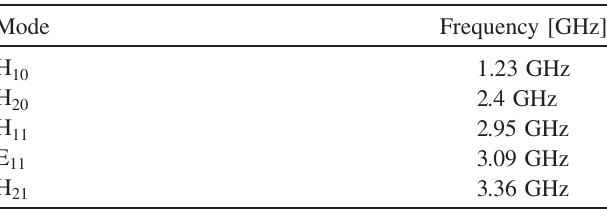
TABLE II. Modes and their cut off frequency in the vacuum chamber of CERN SPS.